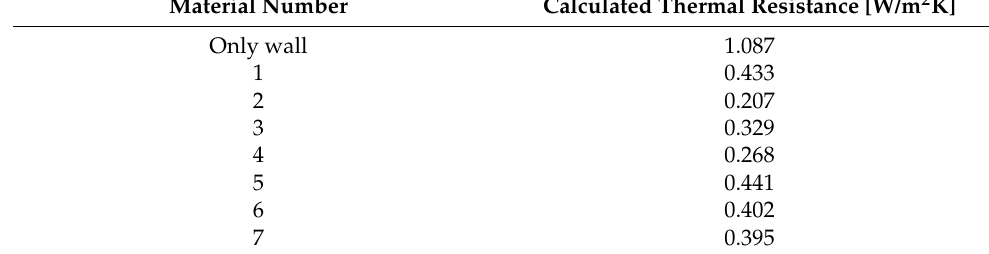
Figure A5. Wall type 3.1: stratigraphy with thicknesses and conductivities for the different layers. The numbers start from the outside. Table A3. Wall type 3.1: thermal transmittance reached with different heat-reflective materials. Material Number